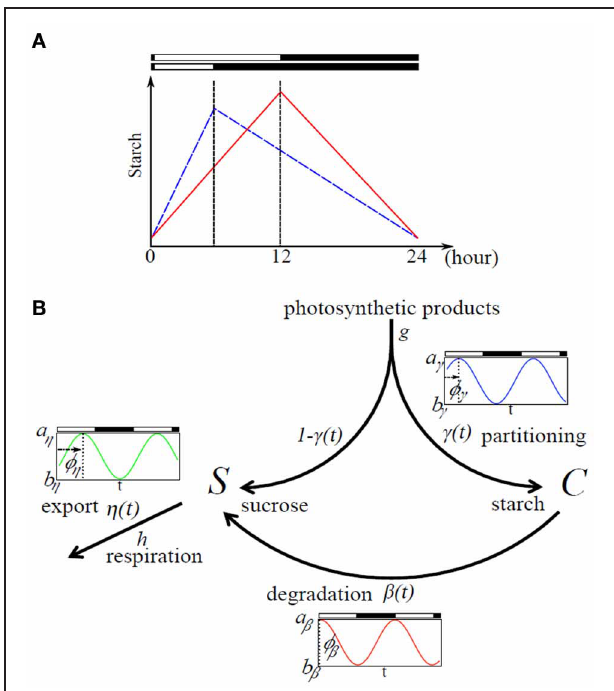
FIGURE 1 | Typical starch diurnal pattern in a long (LD) and short day (SD) (A) and flow chart of the model (B). (A) Scheme of starch idealized diurnal pattern in LD (12h light/12h dark; red) and SD (6h light/18h dark; blue) in plant leaves. The rate of starch synthesis is larger in short days whereas the degradation rate is smaller. This allows the leaves avoiding running out of starch, and therefore sucrose during night. (B) Flow chart of the model. Rates γ ( t ) , β ( t ) , and η ( t ) can be circadian regulated with a phase shift φ i ( i ∈ { γ , β , η } ); a i and b i represent the maximum and minimum values of oscillation of the rate i ,